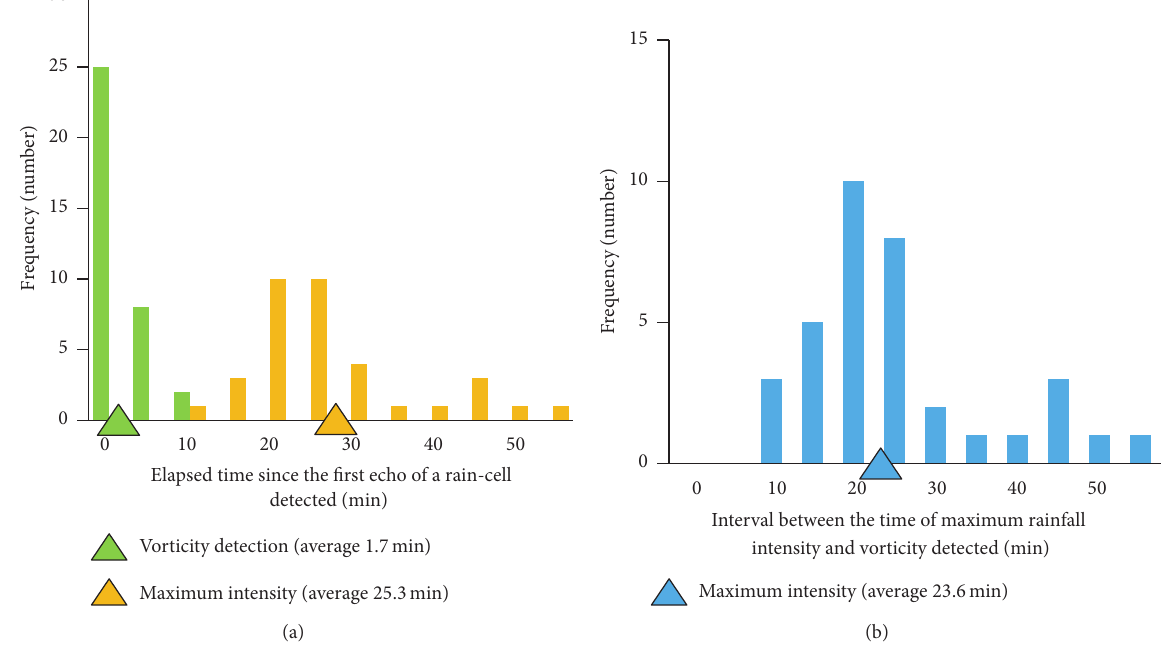
Figure 8: The statistics of the elapsed time since the first echo of a rain-cell was detected: (a) green bars: the time interval between the vorticity detection and the first radar echo detection; orange bars: the time interval between the maximum rainfall intensity observation and the first echo detection; (b) blue bars: the time interval between the maximum rainfall intensity observation and the vorticity detection.